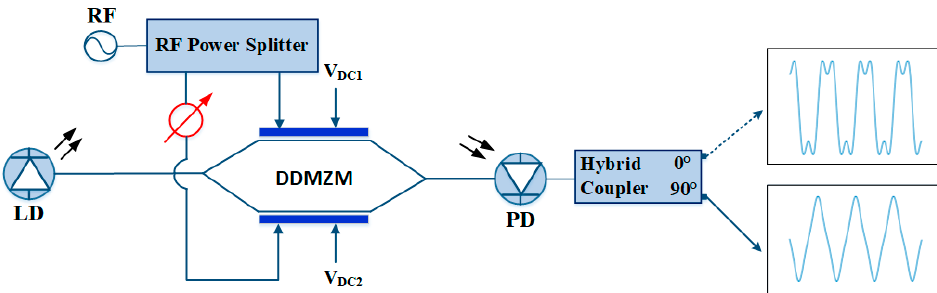
Figure 1. Schematic diagram of the proposed full-duty-cycle square and triangular pulses generator